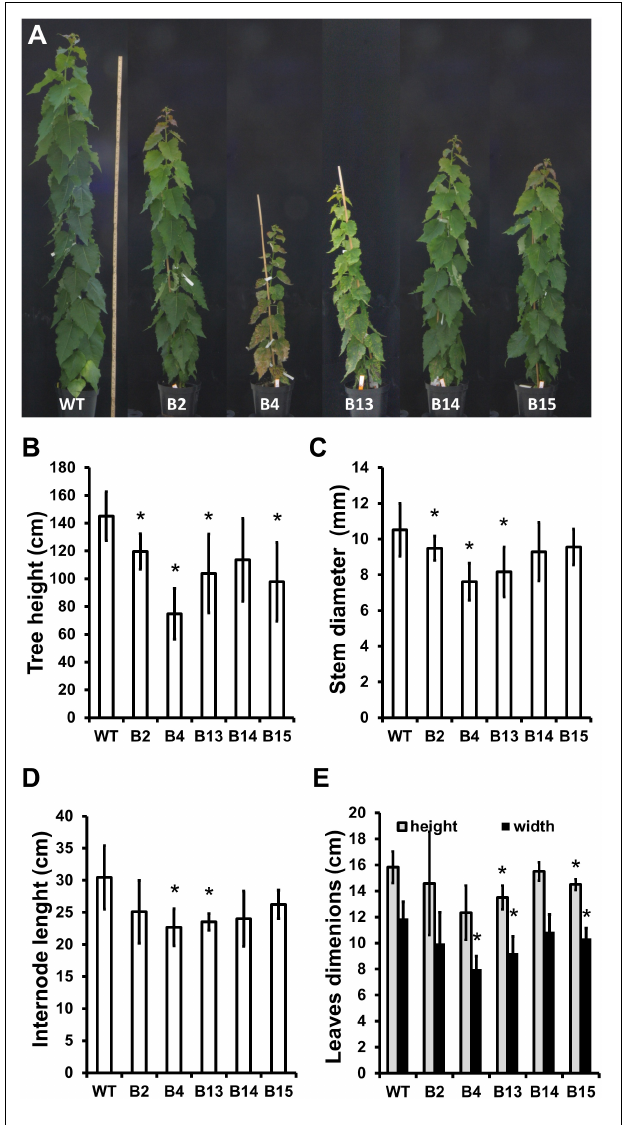
FIGURE 1 | Phenotypic characterization of transgenic hybrid aspen trees expressing 35S : POPACAULIS5 construct (“POPACAULIS5” trees). Overall growth (A) , tree height (B) , stem diameter (C) , internode length (D) and leaf dimensions (E) is shown in 2-month-old wild type (WT) and transgenic POPACAULIS5 trees. Values are means ± SD of at least six biological replicates. The asterisk indicates significant differences from the wild type ( p < 0.05, Student’s t